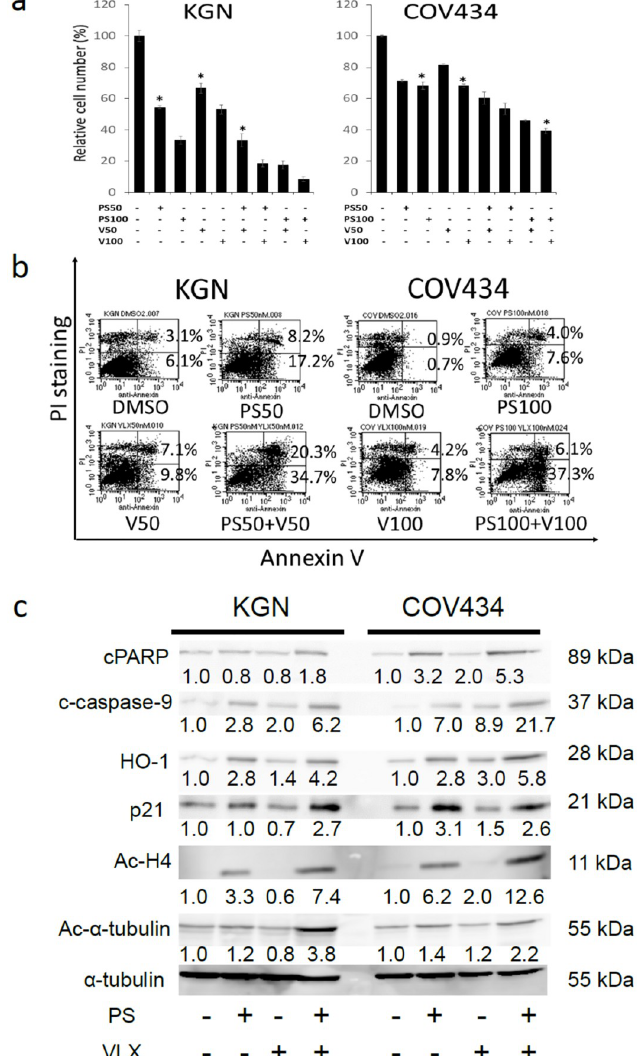
Fig 2. The combined treatment of PS with a deubiqutinase inhibitor, VLX1570 showed the additive effect on KGN and COV434 cell lines. a) KGN and COV434 were cultured with PS (0–100 nM), VLX1570 (0–100 nM) or both for 48 hr. Cytotoxicity was estimated by MTT assay. The data represent the mean values with SD from five independent experiments. Statistical differences were evaluated and presented by asterisks in two cell lines, if p -values were less than 0.05. PS: panobinostat, V: VLX1570. b) KGN and COV434 were cultured with PS (0–100 nM), VLX1570 (0–100 nM) or both for 48 hr. The fraction of apoptosis cells was measured by flow cytometry analysis using annexin V/ PI dual staining. PS: panobinostat, V: VLX1570. c) KGN and COV434 were cultured with PS (0–100 nM), VLX1570 (0–100 nM) or both for 24 hr. The cell lysates of each cell line were analyzed by immunoblotting analysis for detection of p21, cleaved PARP (cPARP), cleaved caspase-9 (c-caspase-9), heme oxygenase-1 (HO-1), acetylated histone H4 (Ac- H4) and acetylated α -tubulin (Ac- α -tubulin). α -tubulin was used as a loading control. The number of protein bands was measured by densitometry and the ratio was adjusted as 1.0 in the untreated sample and the changes of the ratio of treated samples relative to untreated sample were indicated.